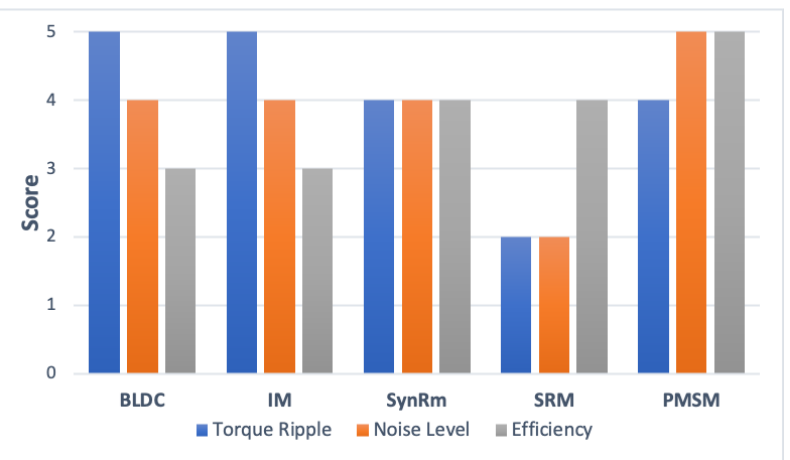
Figure 13. Comparison of efficiency, noise and torque ripple factors for the 5 researched motors score.